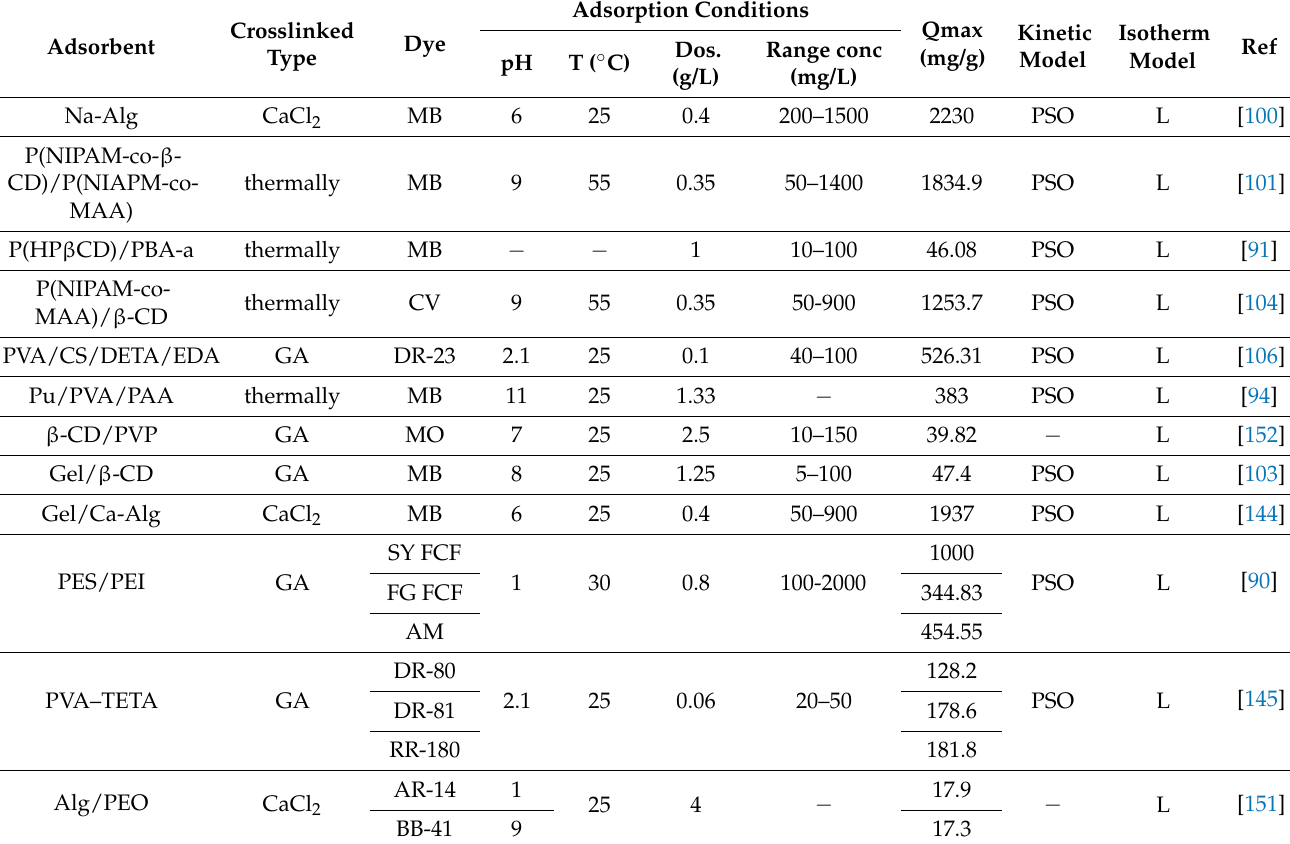
Table 4. Crosslinked EPNFs as adsorbent for removal of